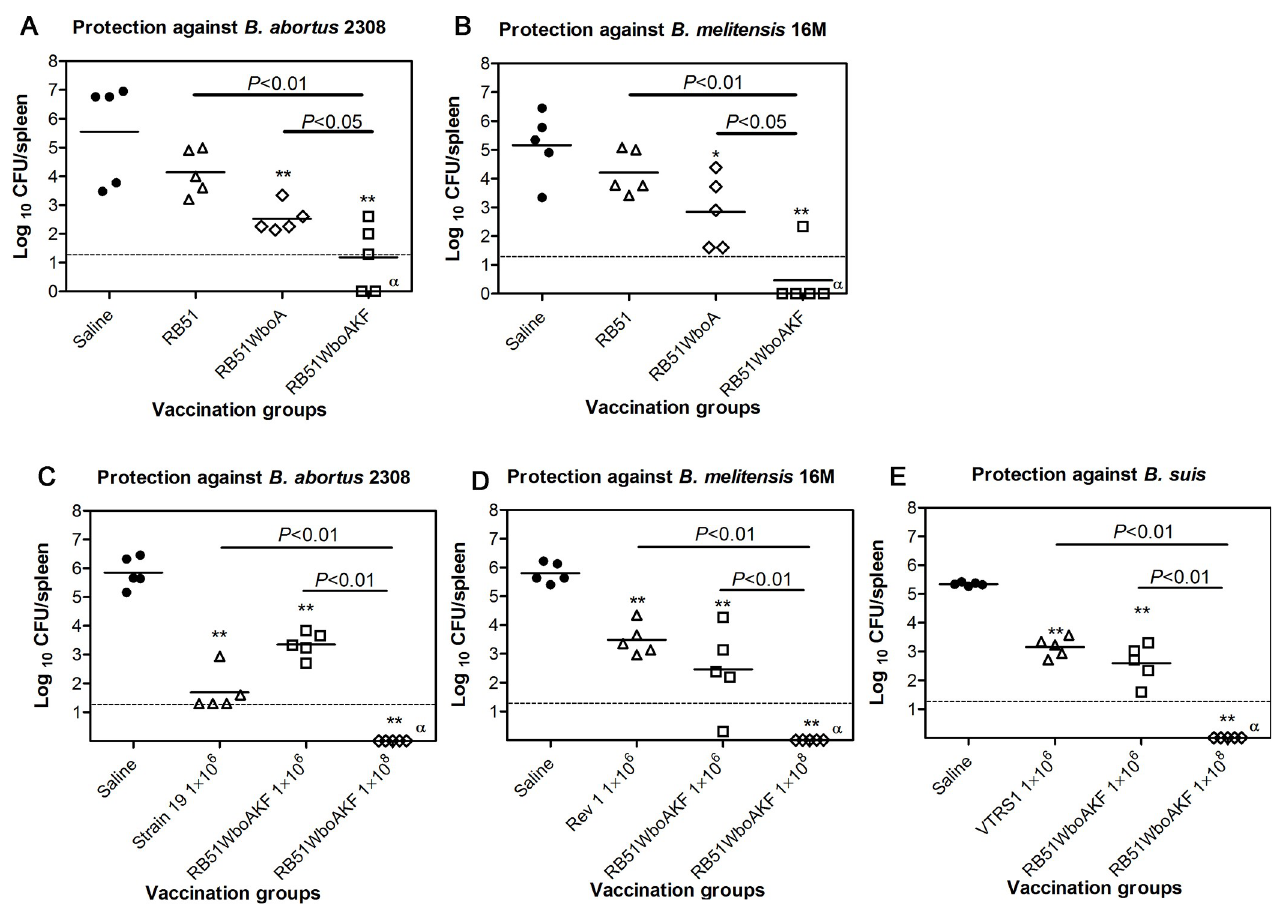
Fig 11. Protection of mice against challenge with virulent strains B . abortus 2308, B . melitensis 16M or B . suis 1330. Mice were vaccinated with the indicated strains or inoculated with saline alone were challenged with (A and C) B . abortus 2308, (B and D) B . melitensis 16M and (E) B . suis 1330, and 2 weeks post-challenge, the mice were euthanized and the Brucella CFU in their spleens were determined. Results are shown as mean ± standard deviation (n = 5) of the log CFU of Brucella recovered from spleens. Horizontal broken line above the x-axis indicates the lower limit of detection ( < 20 CFU/spleen). Asterisks indicate statistically significant differences from the corresponding saline group. � , P < 0.05; �� , P < 0.01; ��� , P < 0.001. α : no bacteria were recovered on plating the entire homogenate.